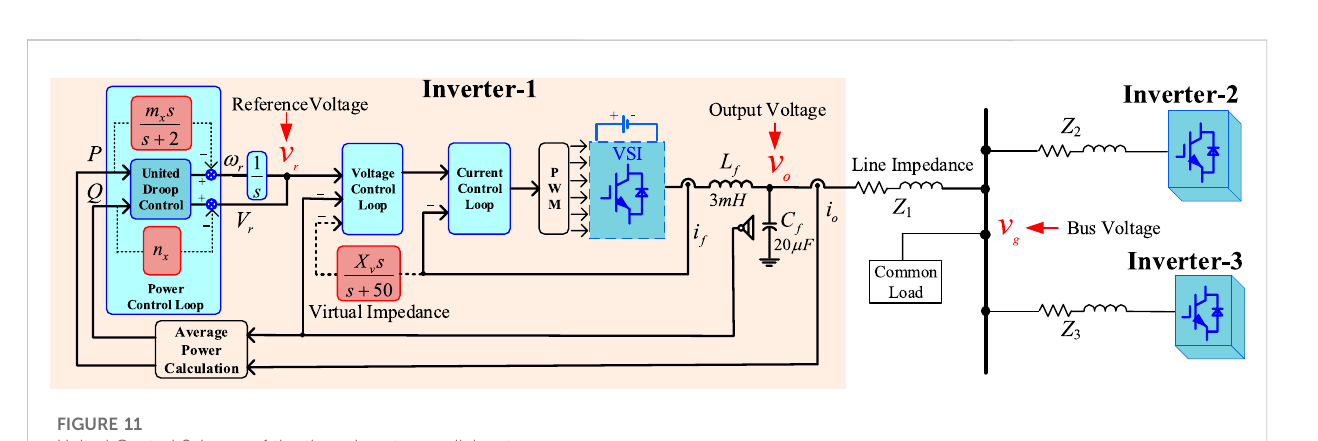
According to the small-signal analysis, the overall small-signal block diagram models of the stand-alone system in the purely- inductive, equally resistive-inductive, and purely-resistive lines are shown in (a.1), (a.2), and (a.3) in Figure 9, respectively. As seen, the strength of the internal coupling effect of the active-reactive control